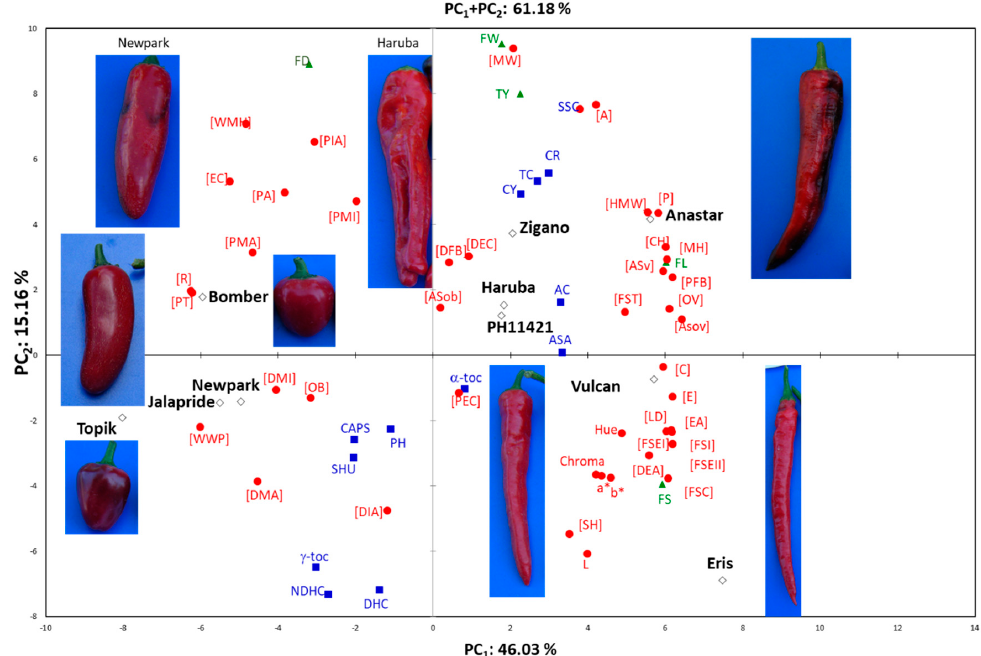
Figure 2. Loading plot of the first (PC 1 ) and the second (PC 2 ) principal components showing the variations for the 62 traits evaluated on ten chilli hybrids. Agronomic traits are indicated in green font with a triangle symbol; biochemical traits in blue font with a square symbol; size and shape (in squared brackets) and colour parameters are in red font with a circular symbol. The direction and distance from the centre of the biplot indicate how each trait contributes to the first two components. Fruit photos highlight main features of the studied material (not all cultivar photos are included).